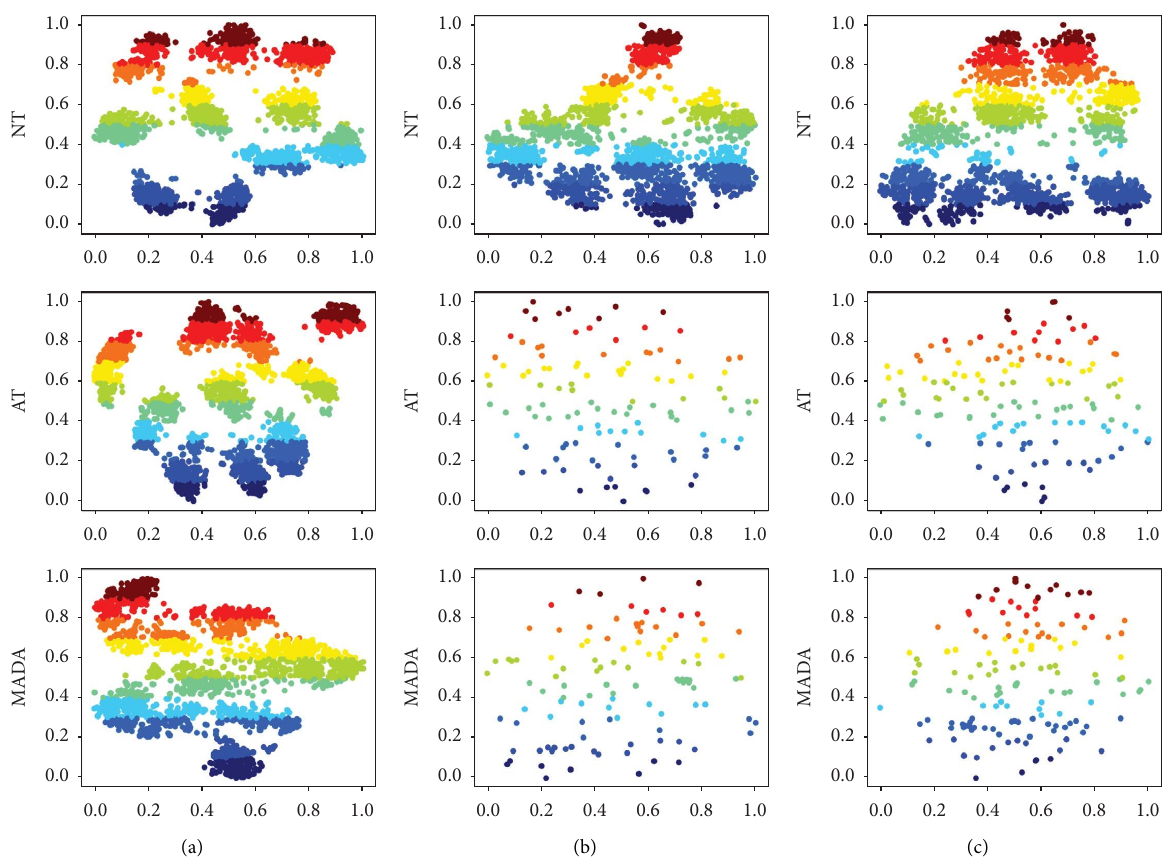
Figure 2: t -SNE visualizations for the exacted features of testing data and adversarial testing data from FGSM and PGD for the MNIST dataset. (a) Clean. (b) FGSM. (c)